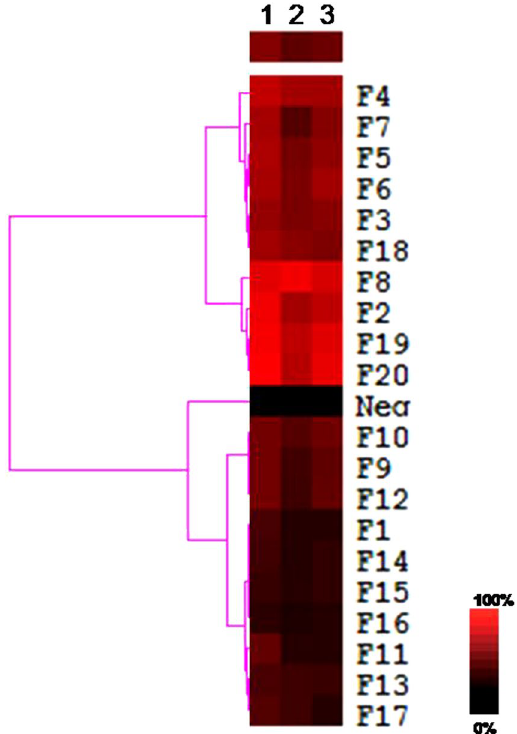
Figure 5. The heat map of PN fractions. This heat map was obtained by using similarity analysis of the inhibition rate of the each fraction. For each inhibition profile, the results were color coded – red: high inhibition effect; black: no inhibition. False color scale bar is included to assist the data visualization. N = 3 (x axis are 3